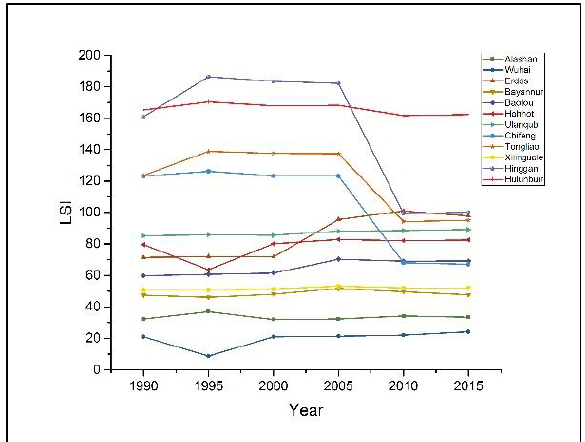
Figure 7. Landscape shape index of cities in Inner